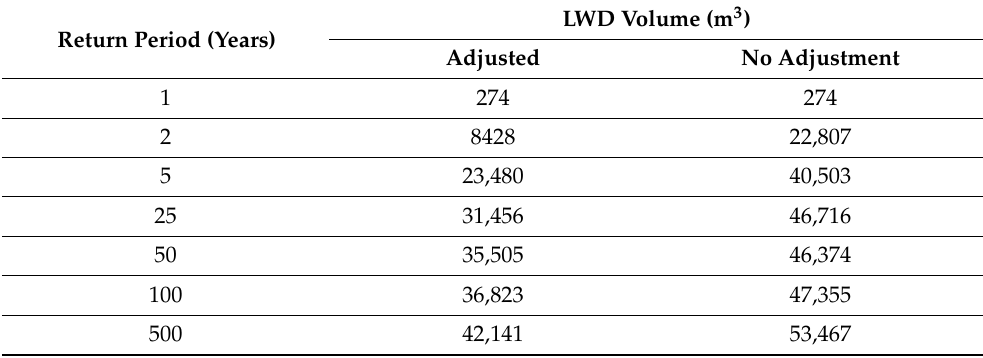
Table 4. Extrapolated transport volume of LWD in Lake Oroville from all burned